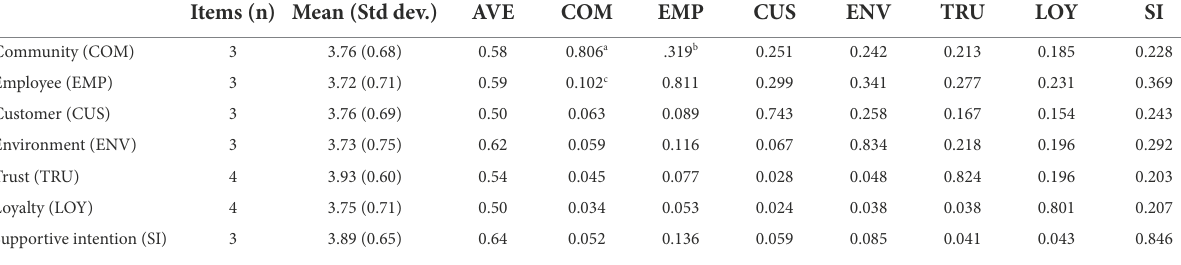
TABLE 3 The CFA results and descriptive results of the constructs. Items (n) Mean (Std dev.)